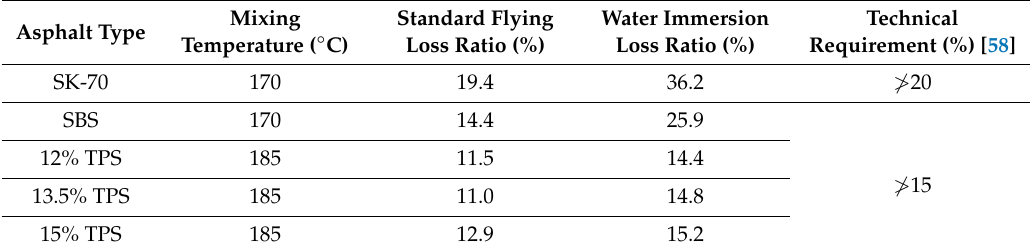
Table 7. Results of Cántabro test under water-immersion.